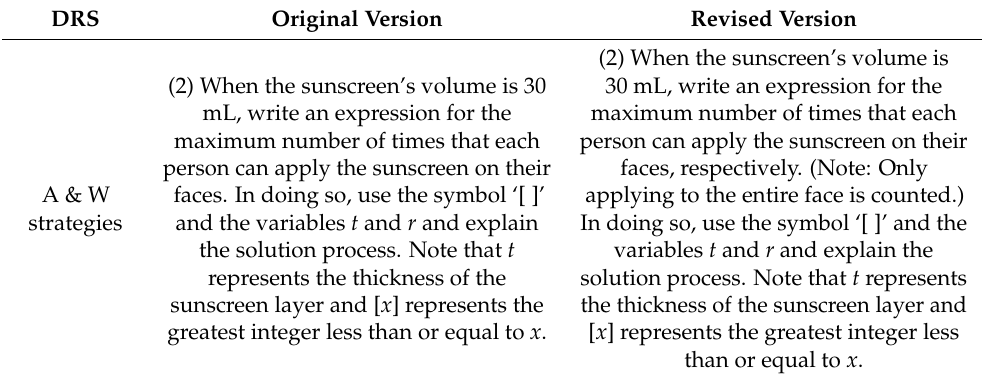
Table 10. A and W Strategies.